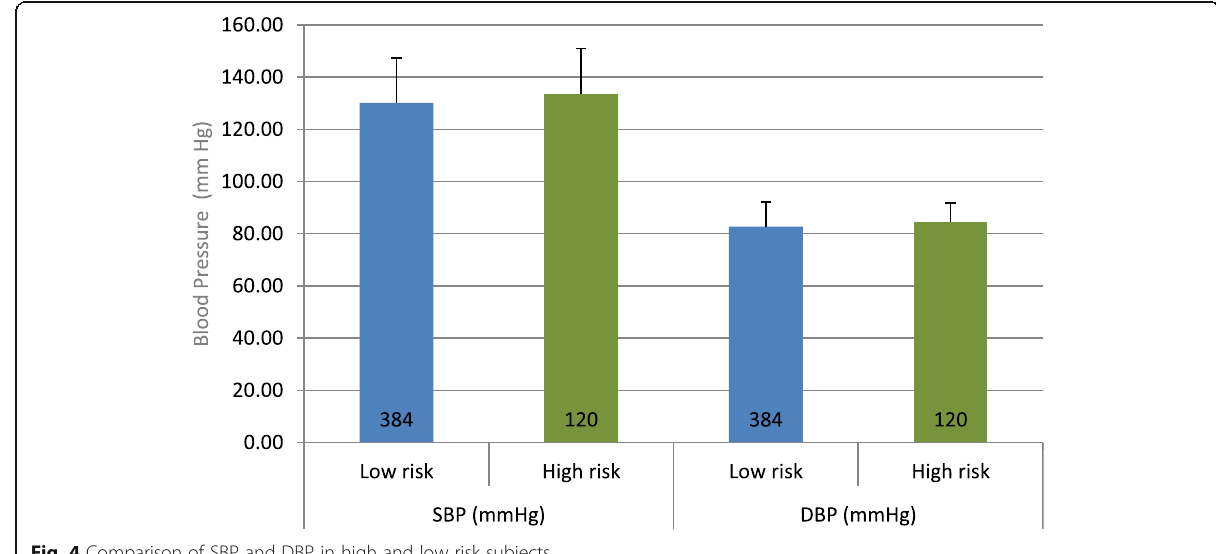
Fig. 4 Comparison of SBP and DBP in high and low risk